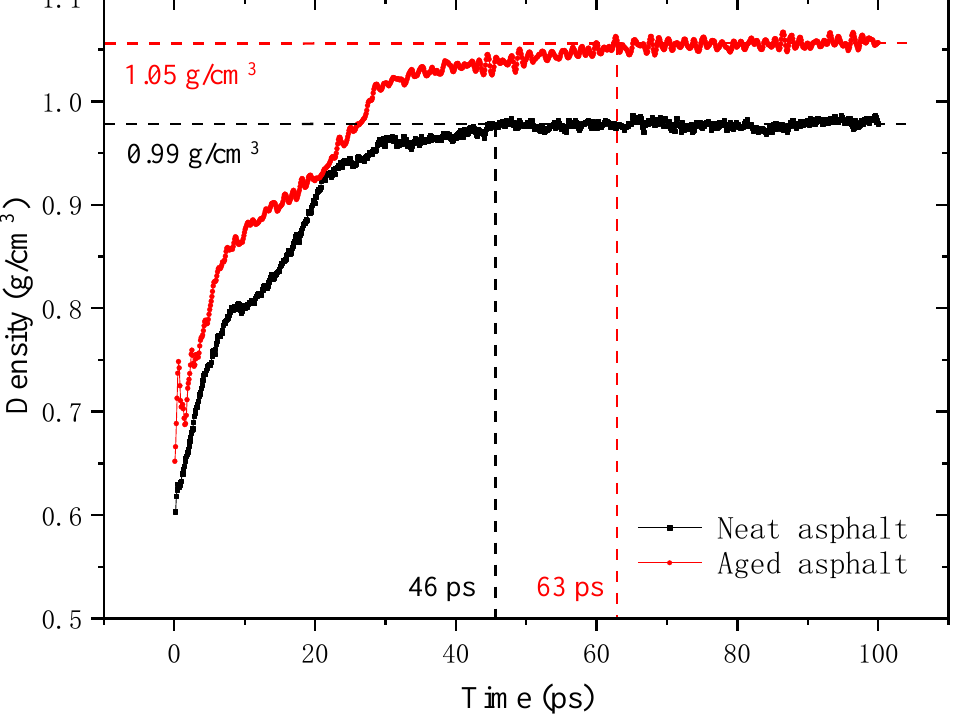
Figure 5. Density variation of the self-healing model of neat and aged asphalt binder with 1 nm crack at 298.15 K.